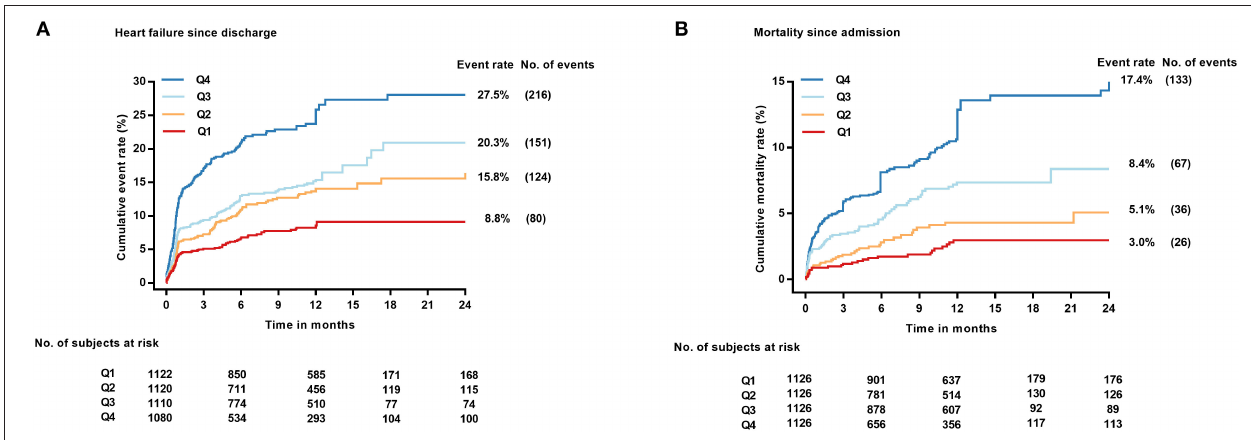
and small sample